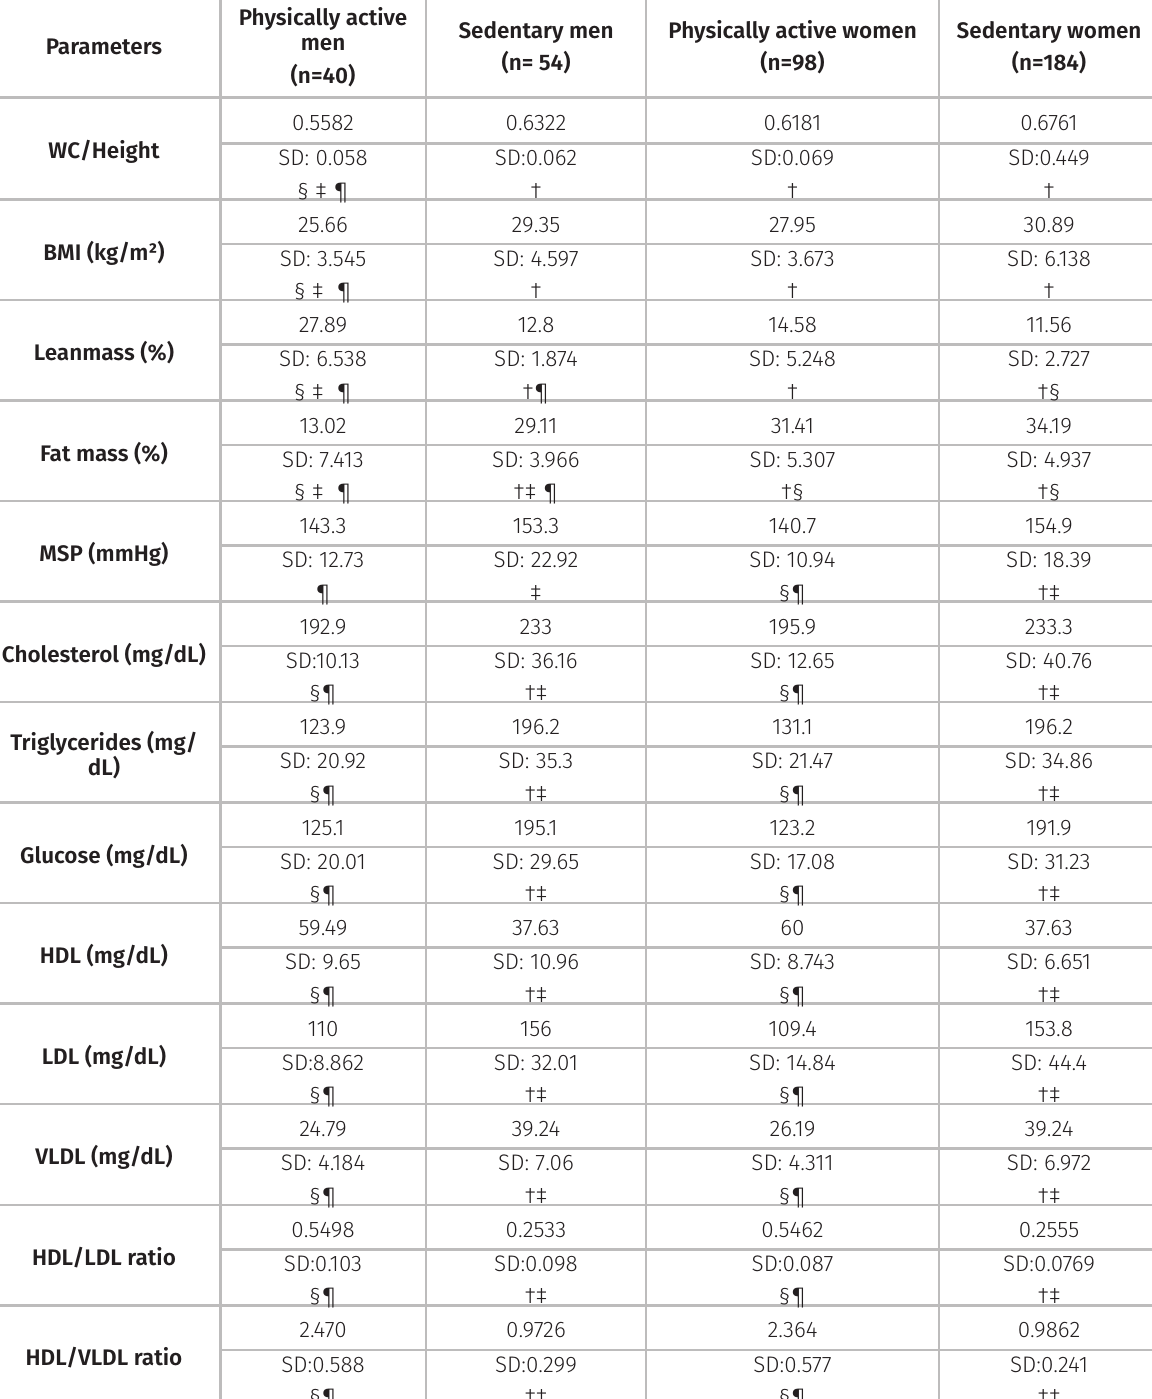
Table I. Characterization of anthropometric, blood pressure data, biochemical and cytokine markers in diabetics and hypertensive